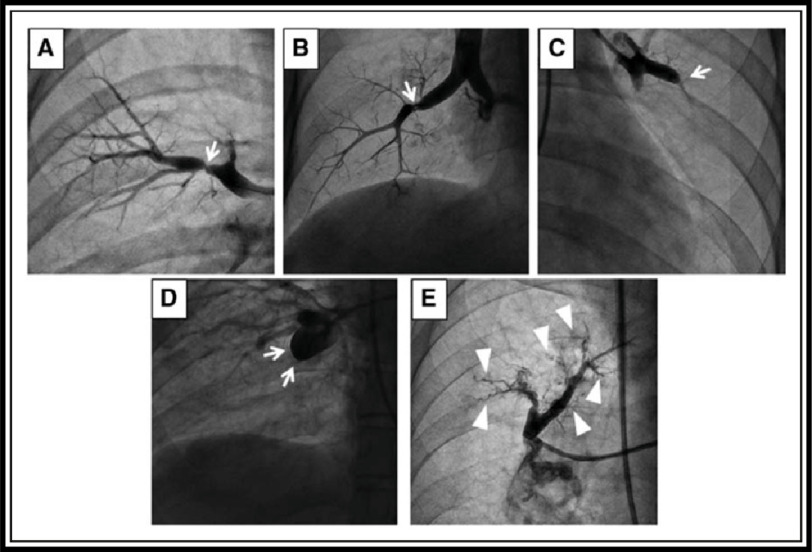
Angiographic classification of lesion morphology based on the lesion opacity and the blood flow distal to the lesion.(A) Ring-like stenosis lesion. (B) Web lesion. (C) Subtotal lesion. (D) Total occlusion lesion. (E) Tortuous lesion. Type A–D lesions are located proximal to the subsegmental pulmonary artery, namely, the segmental and subsegmental arteries. Type E lesions are located distal to the subsegmental artery; Adapted from Kawakami et al. Novel angiographic classification of each vascular lesion in chronic thromboembolic pulmonary hypertension based on selective angiogram and results of balloon pulmonary angioplasty128.